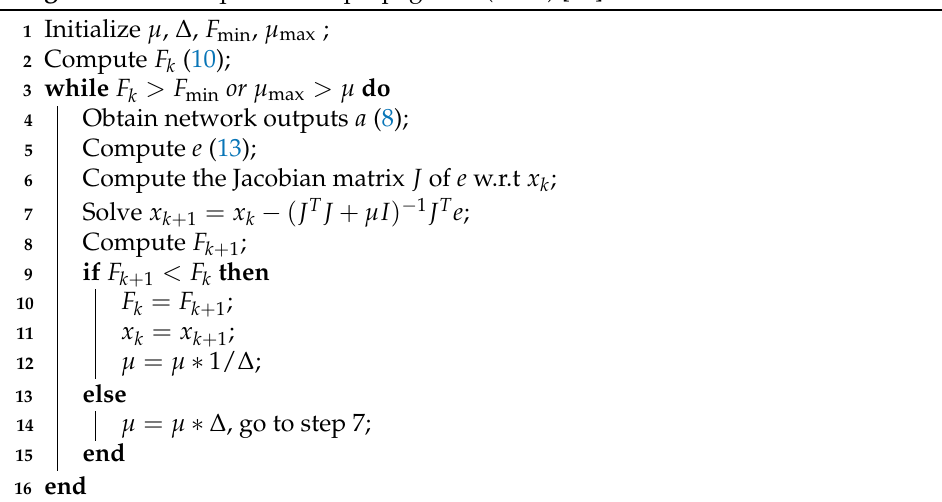
Algorithm 2: Marquardt backpropagation (MBP)